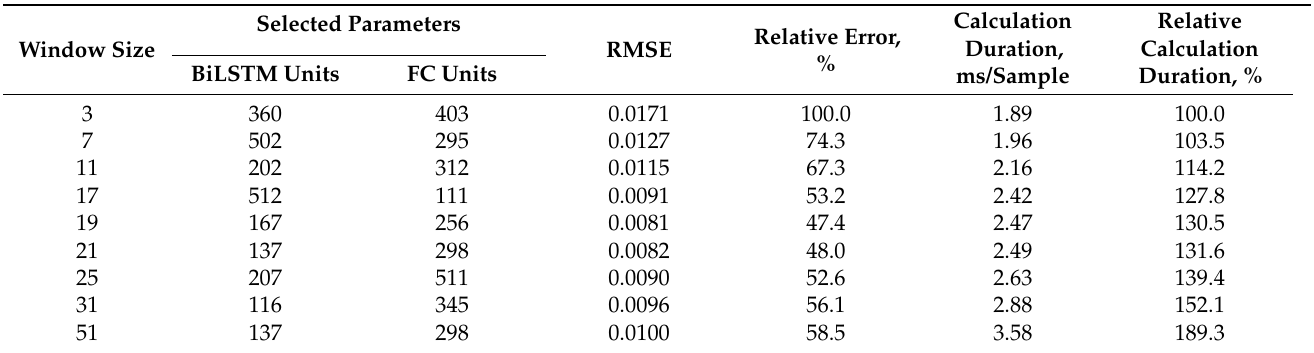
Table 3. Hyperparameter optimisation results with performance and calculation duration comparison for each window